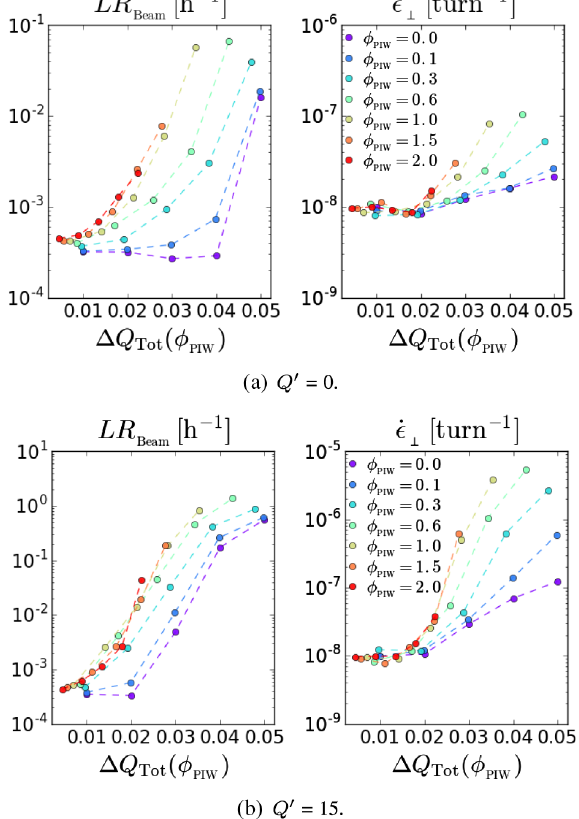
FIG. 8. Beam quality reduction for different combinations of ϕ and ξ with different chromaticities, when Q x ¼ 0 . 31 , PIW Tot Q 0 . 32 , and β (cid:1) 0 . 4 m. q ¼ y ¼